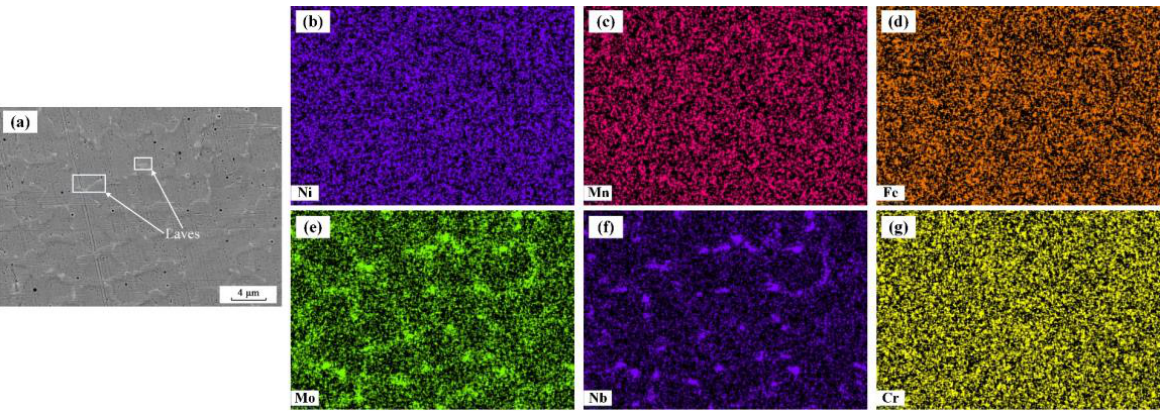
Figure 6. EDS analysis of the top region of laser deposited layer: ( a ) detected region ( b – g ) element maps of Ni, Mn, Fe, Mo, Nb and Cr.